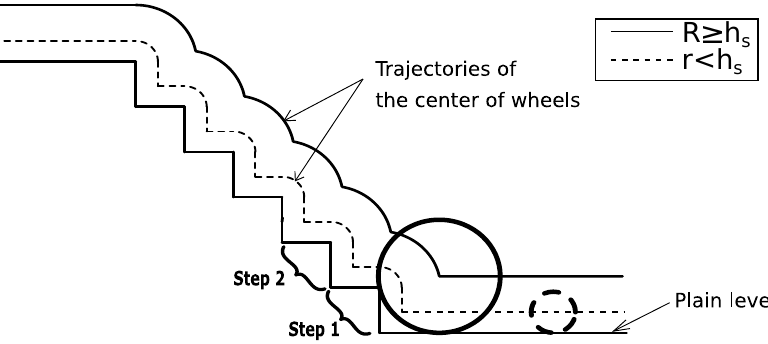
Figure 3. Locus of the wheel center on